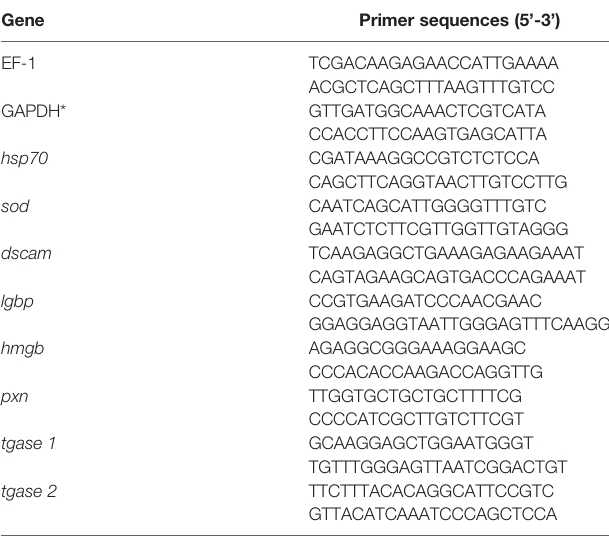
TABLE 1 | Speci fi c primers used for reverse transcriptase